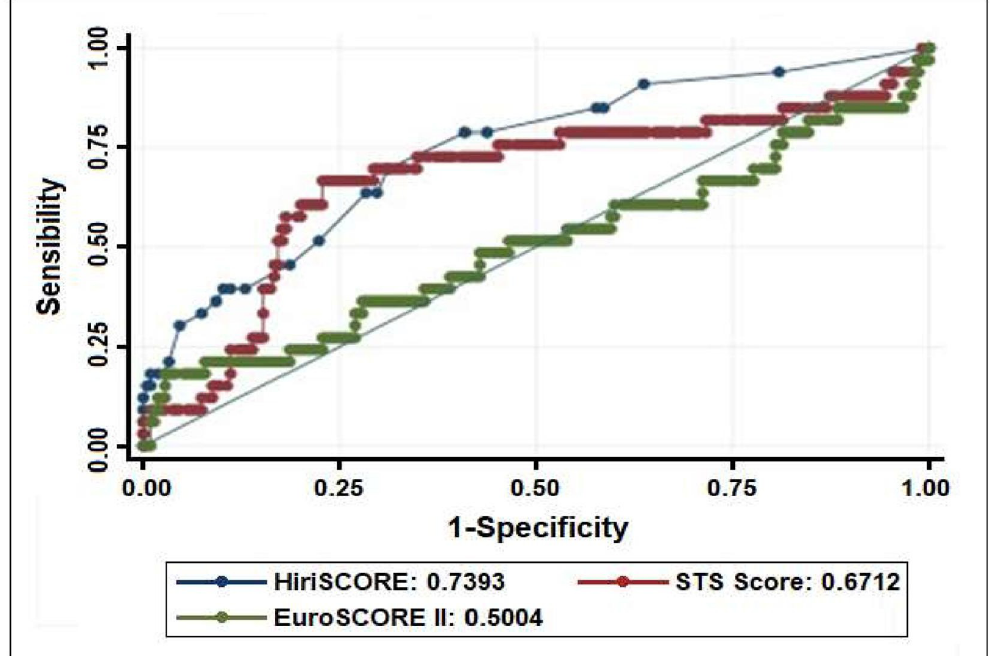
Fig 3. ROC curve for ESII, STS and HiriSCORE models for high-risk